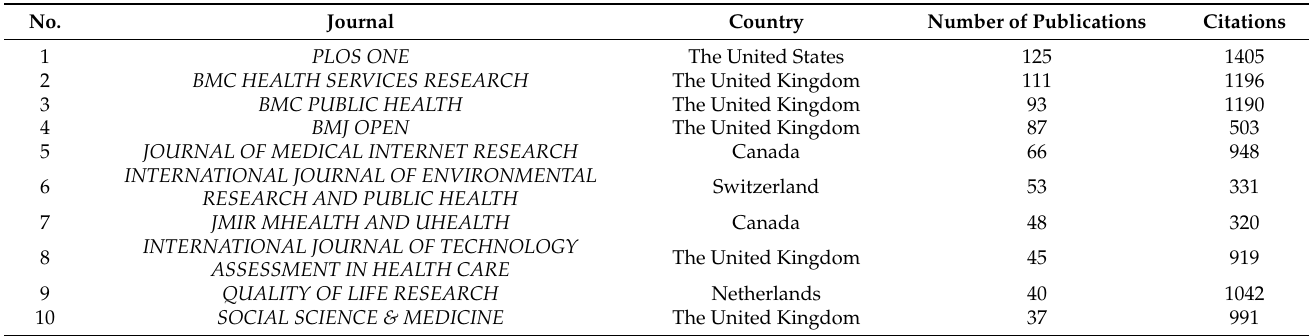
Table 3. Top 10 academic journals in the field of health technology